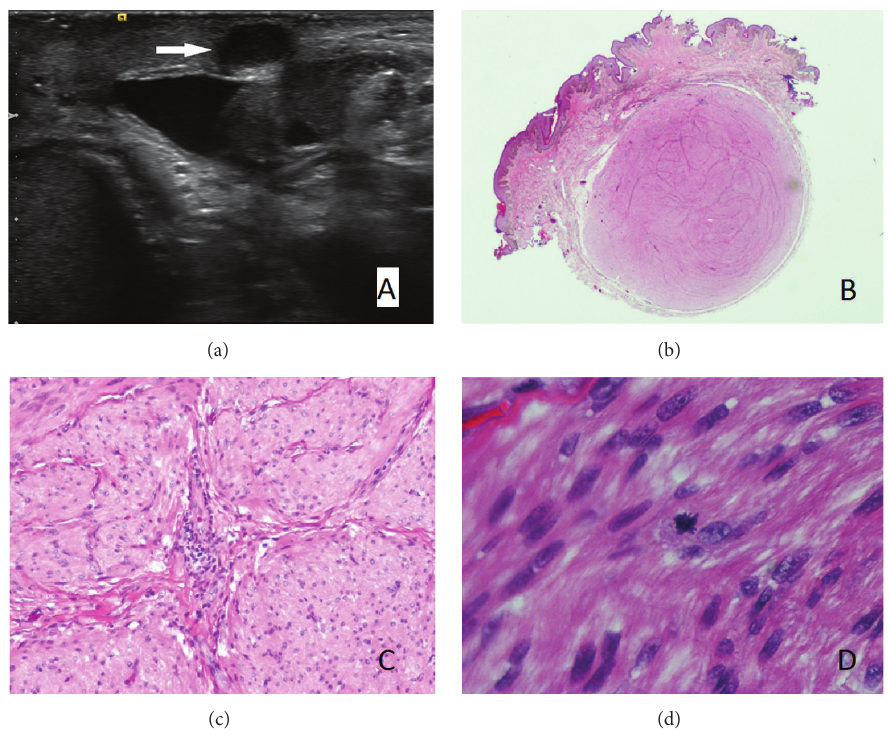
Figure 1: (a) Ultrasound imaging demonstrating hypoechoic mass at left penoscrotal junction. (b) Subcutaneous, unencapsulated, but well- circumscribed scrotal lesion with unremarkable overlying epidermis (H&E × 5). (c) Interlacing fascicles and bundles of smooth muscle with eosinophilic cytoplasm and elongate, cigar-shaped nuclei (H&E × 100). (d) Rare mitotic figure (H&E ×